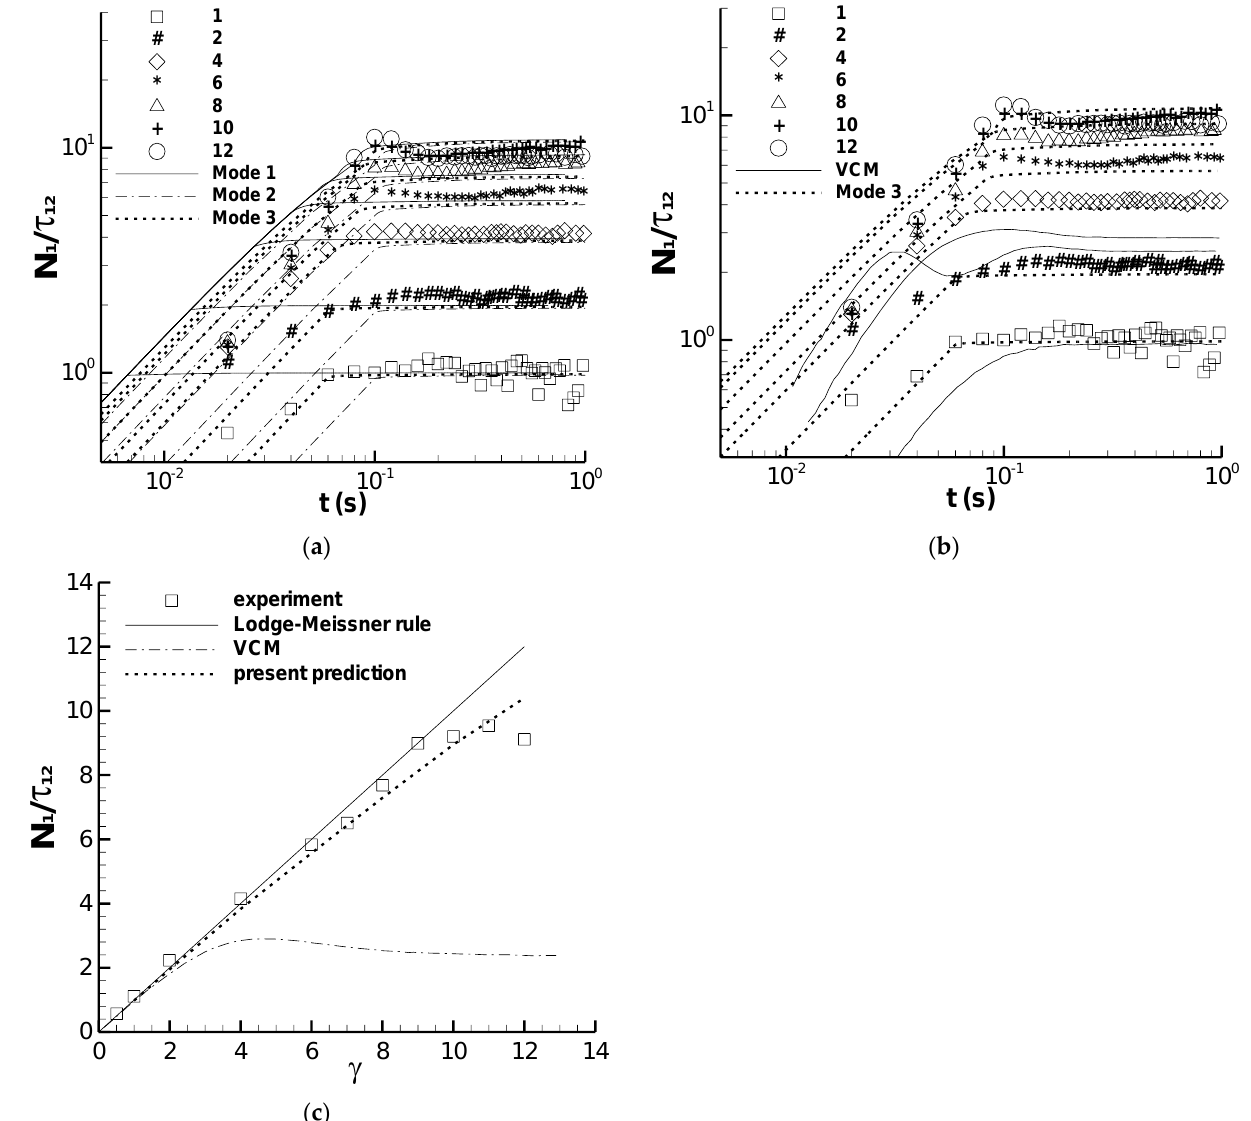
Figure 6. ( a ) Relation of N 1 /τ 12 versus t obtained using three shear rate modes, ( b ) N 1 /τ 12 of both Mode 3 and VCM model, ( c ) the correlation between N 1 /τ 12 and γ. The symbols represent the experimental data in Figure 5 of Pipe et al. [3], and the lines are calculations, in which “VCM” and “Lodge-Meissner rule” are from Pipe et al. [3], and “Mode 1”, “Mode 2”, “Mode 3”, and “present prediction” are the present calculations.